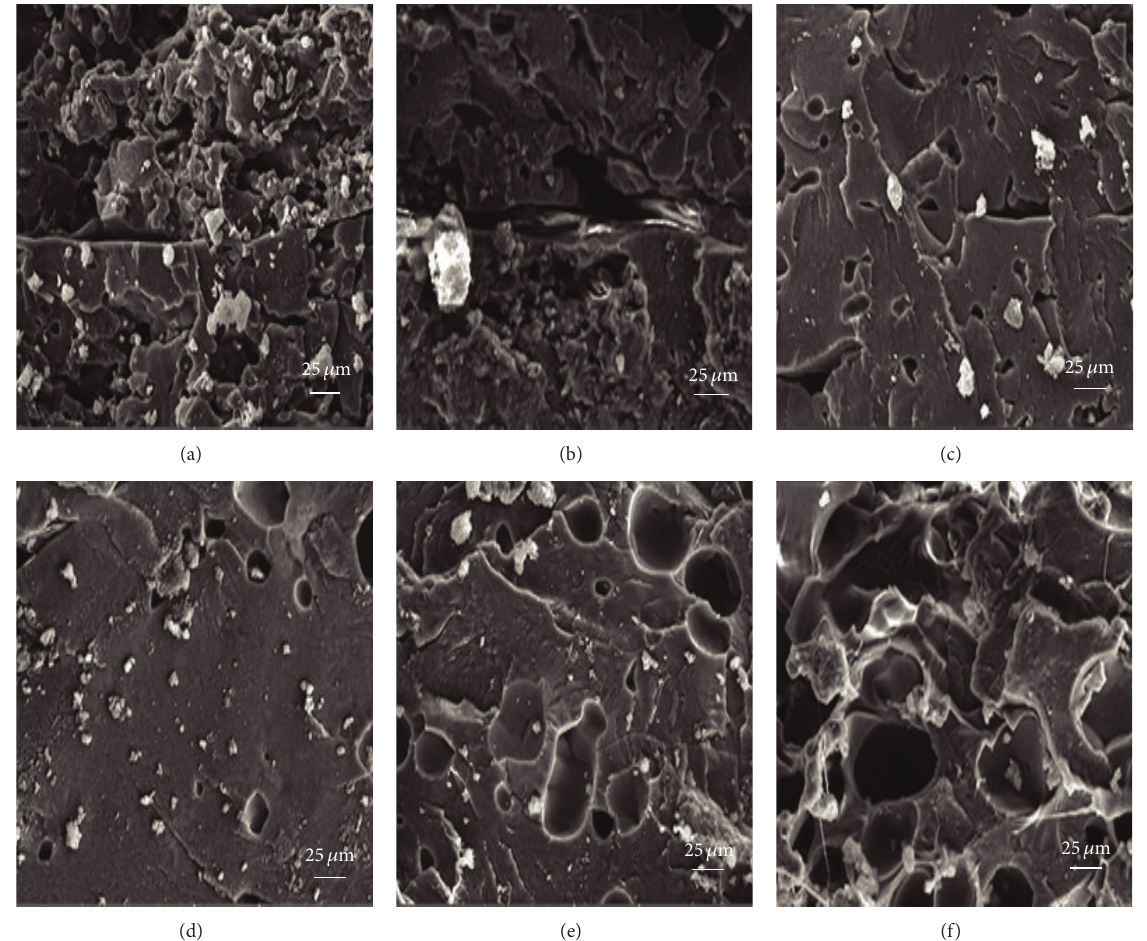
Figure 3: Fractured cross sections of PVDF scaffolds sintered at different energy density of (a) 0.66; (b) 0.96; (c) 1.26; (d) 1.56; (e) 1.86; (f) 2.16 J/mm 2 .